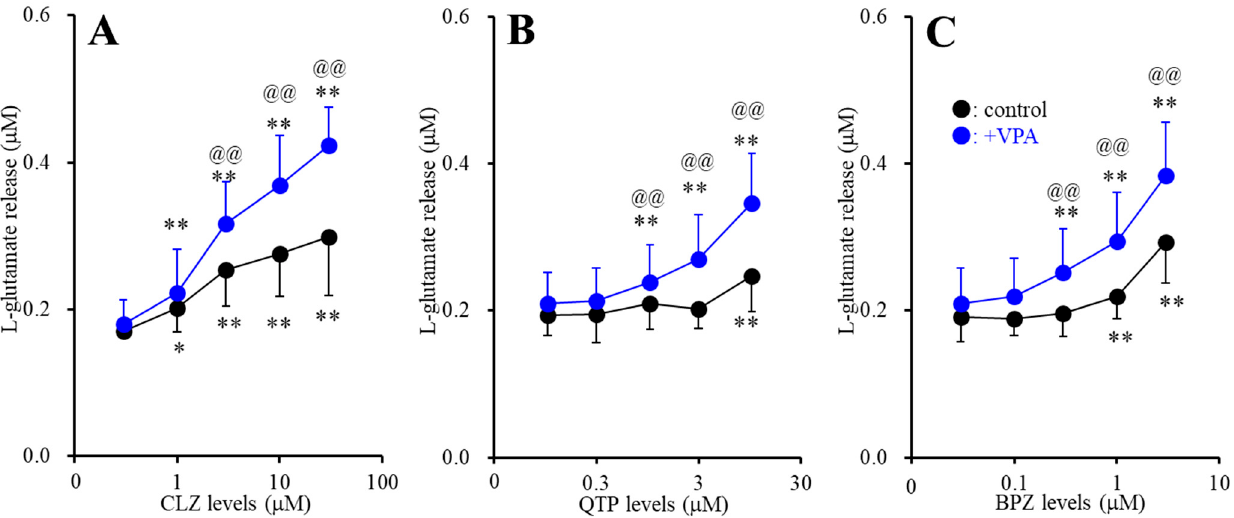
Figure 2. Interaction between subchronic administration of therapeutic-relevant concentration of valproate (VPA: 500 μ M) and acute administration of antipsychotics, CLZ ( A ), QTP ( B ) and BPZ ( C ) on L -glutamate release through activated hemichannel. Ordinate: mean ± SD ( n = 6) of the high (100 mM) K + with Ca 2+ free artificial cerebrospinal fluid (FCHK-ACSF) evoked astroglial L -glutamate release ( μ M), and abscissa: concentration of CLZ, QTP and BPZ ( μ M). Black and blue circles indicate acute antipsychotics administration alone (control) and combination of subchronic VPA with acute antipsychotics administrations (+VPA), respectively. * p < 0.05, ** p < 0.01: relative to antipsychotics free, @@ p < 0.01: relative to control by multivariate analysis of variance (MANOVA) with Tukey’s post hoc test.